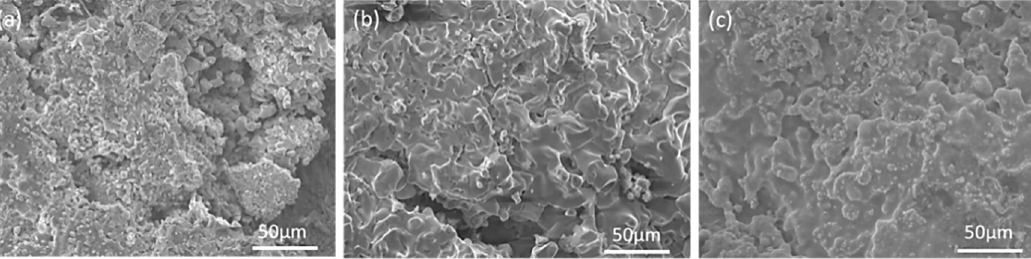
Figure 7. Surface morphology of MoSi 2 -ZrB 2 coatings after oxidation in air at 1250 °C for 60 h: ( a ) mz40, ( b ) mz43 and ( c ) mz45.